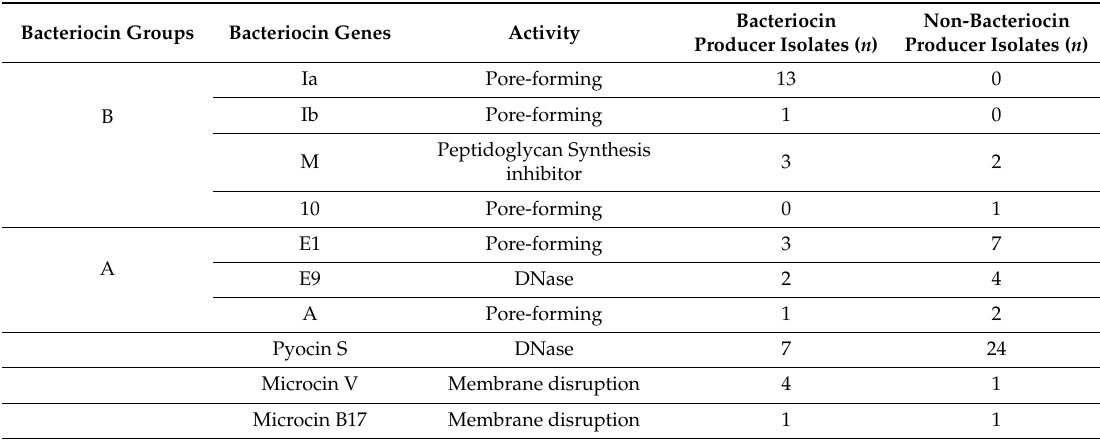
Table 2. Distribution of bacteriocin genes among clinical